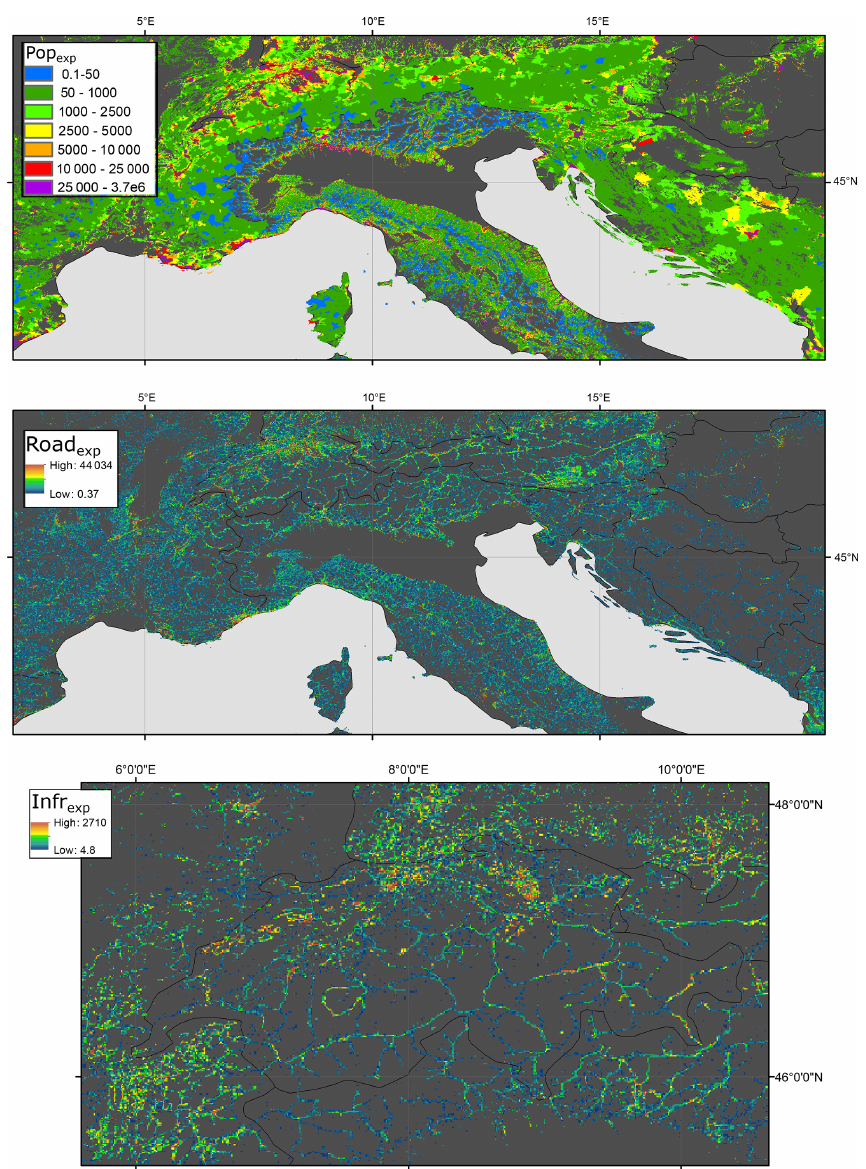
Figure 2. Showing relative exposure of population, critical infrastructure and roads in a snapshot of the world map – in this case, the European Alps and Italy. To improve clarity, the critical infrastructure exposure is shown only for